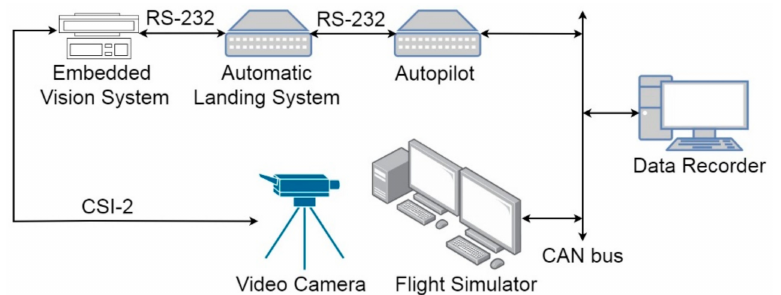
Figure 16. HIL rig configuration for testing picture processing and control algorithms. Adapted from [33].